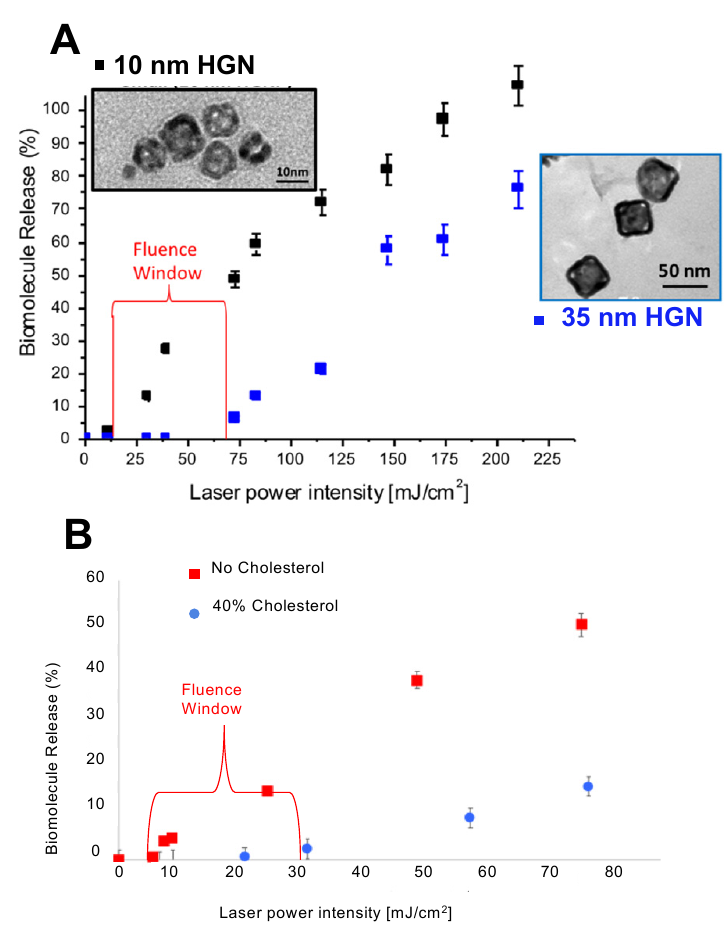
Figure 18. ( A ) Liposomes tethered to different HGN with different light adsorption properties induce calcium release at different laser fluences when irradiated with 800 nm NIR light. This creates a “fluence window” over which one liposome–HGN releases its contents while the second remains intact. ( B ) A fluence window is opened between liposomes with identical HGN but different liposome membrane compositions. Adding cholesterol to DPPC liposomes increases the membrane lysis tension, which increases the laser fluence needed to release calcium. Adapted from [48], published by Nature, 2020.